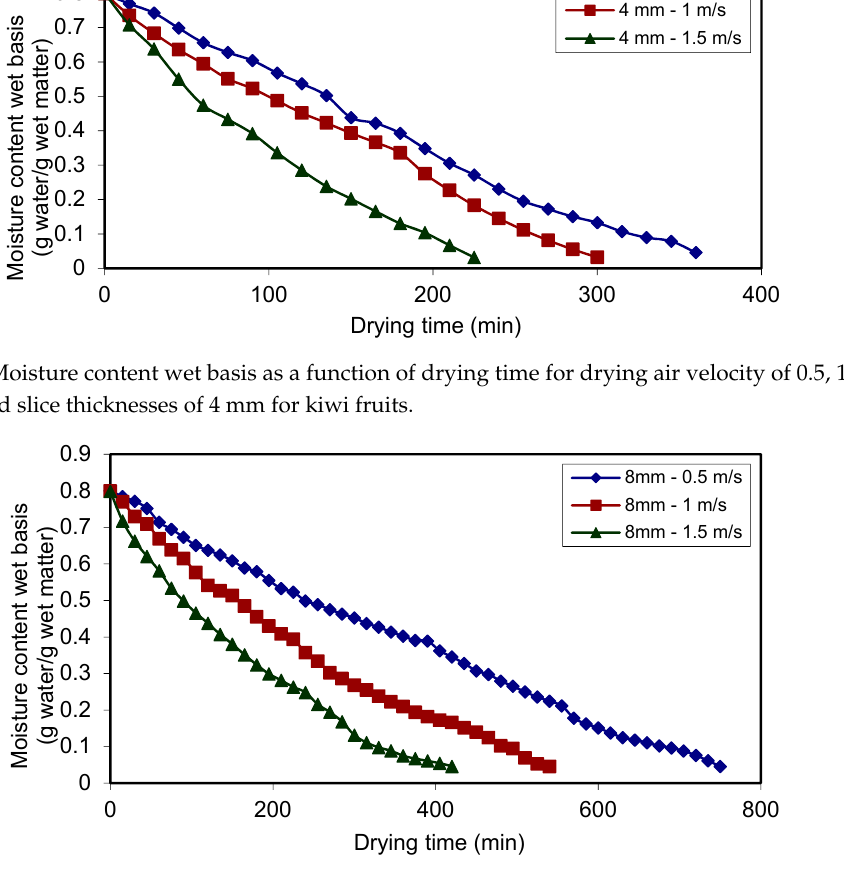
Figure 4. Moisture content wet basis as a function of drying time for drying air velocity of 0.5, 1 and 1.5 m/s and slice thicknesses of 8 mm for kiwi fruits.